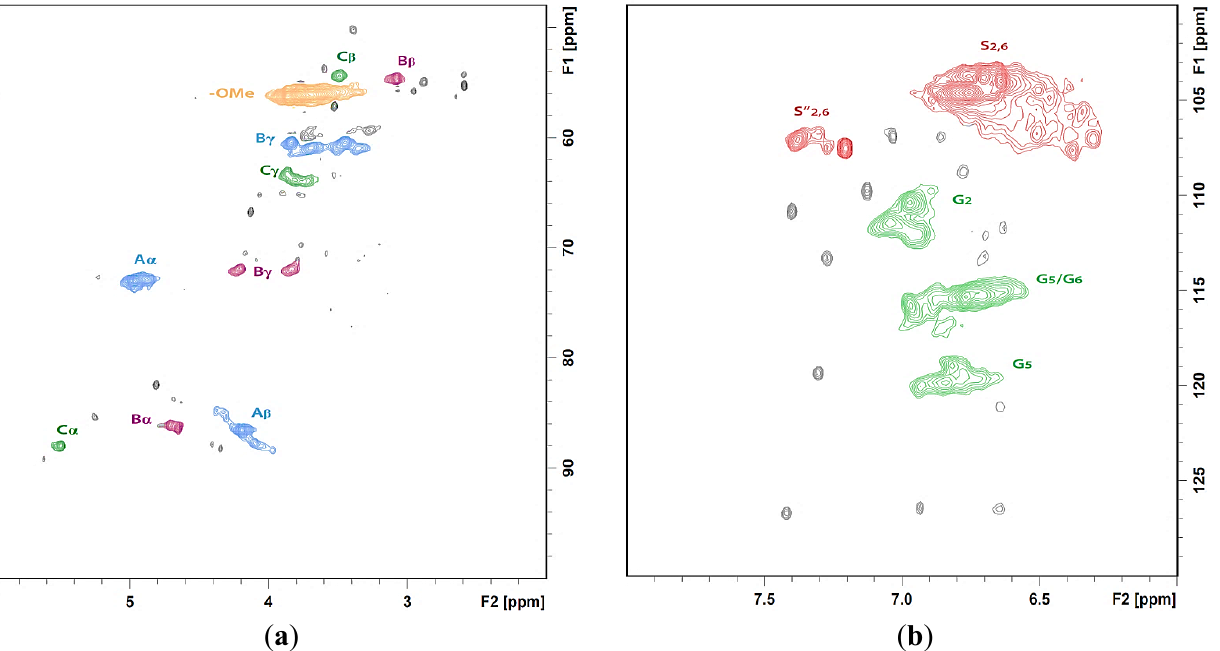
Figure 1. Heteronuclear single quantum coherence spectroscopy (HSQC) spectra of: ( a ) the side chain and ( b ) aromatic region of acetone:water (AW) extract of hot-water extracted sugar maple wood (AW_ESM). The colors and alphabetical nomenclature of the contours correspond to the substructures shown in Figure